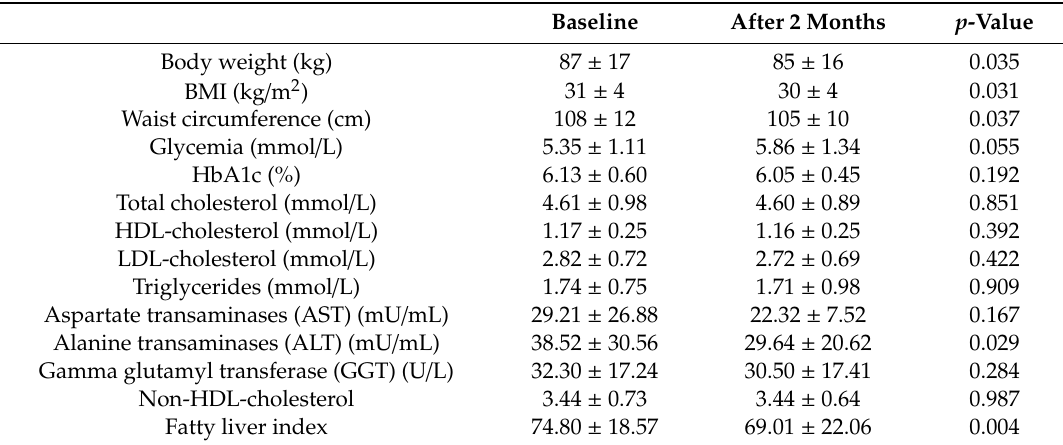
Table 1. E ff ect of extra virgin olive oil (EVOO) with a high oleocanthal (OC) concentration on anthropometric and laboratory parameters ( n = 23).